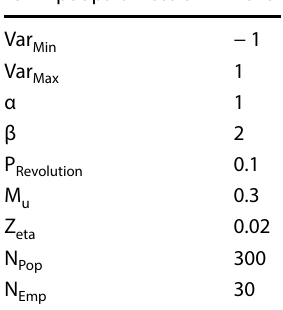
Table 4 Parameters of ICA algorithms